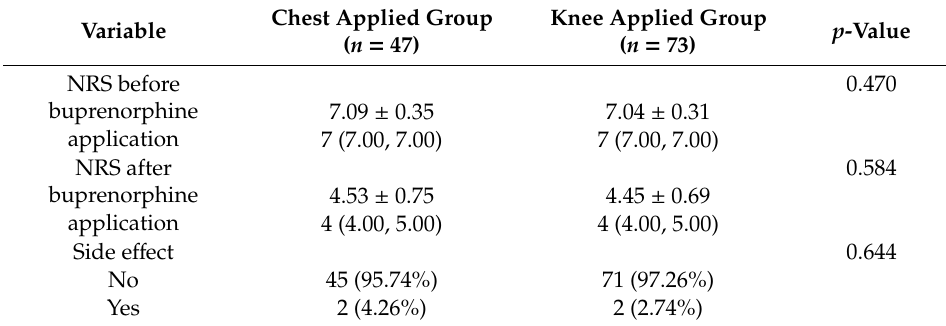
Figure 4. Numeric rating scale (NRS) before buprenorphine transdermal patch application. Table 3. Comparison of the NRS, adverse e ff ects, and compliance between the chest applied group and knee applied group (per protocol analysis).